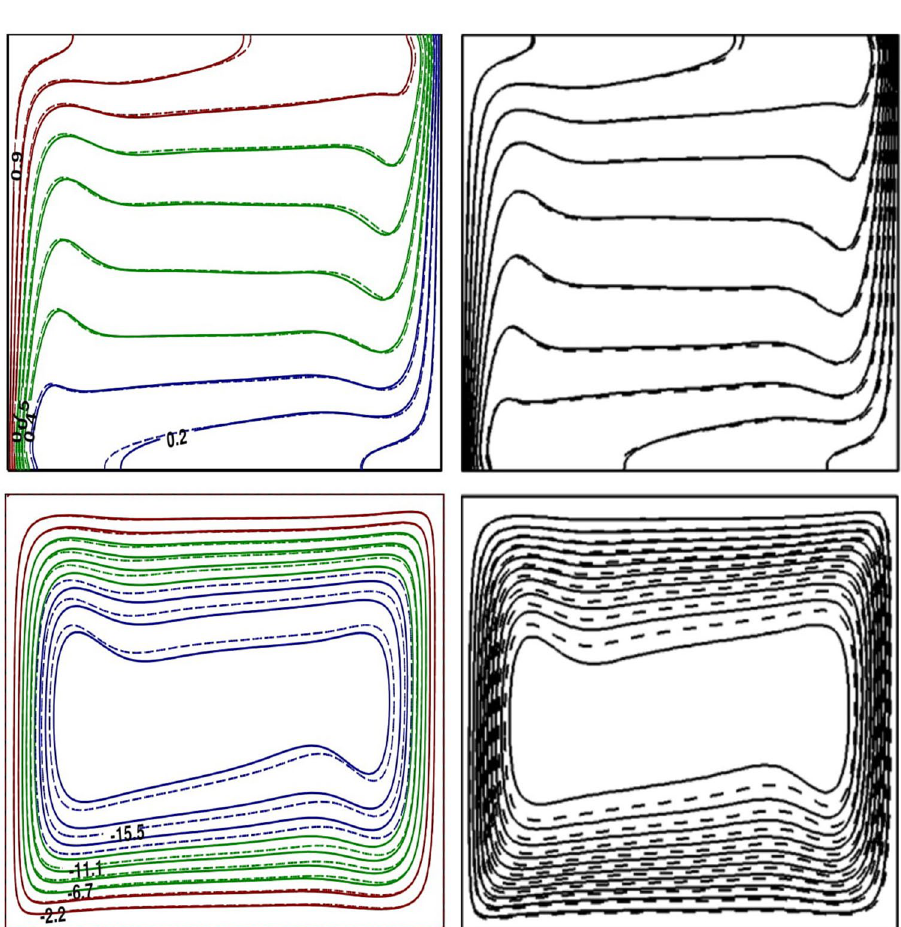
Figure 2. Comparison of simulations (left) with the results of Ho et al. 28 (right). Base fluid (dotted line) and NF (solid